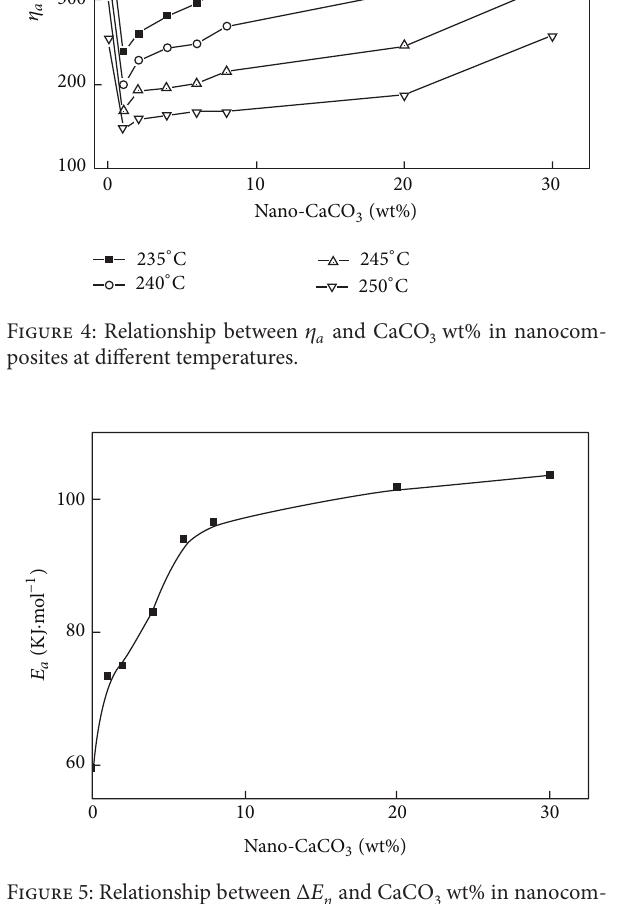
Figure 5: Relationship between Δ𝐸 𝜂 and CaCO 3 wt% in nanocom-